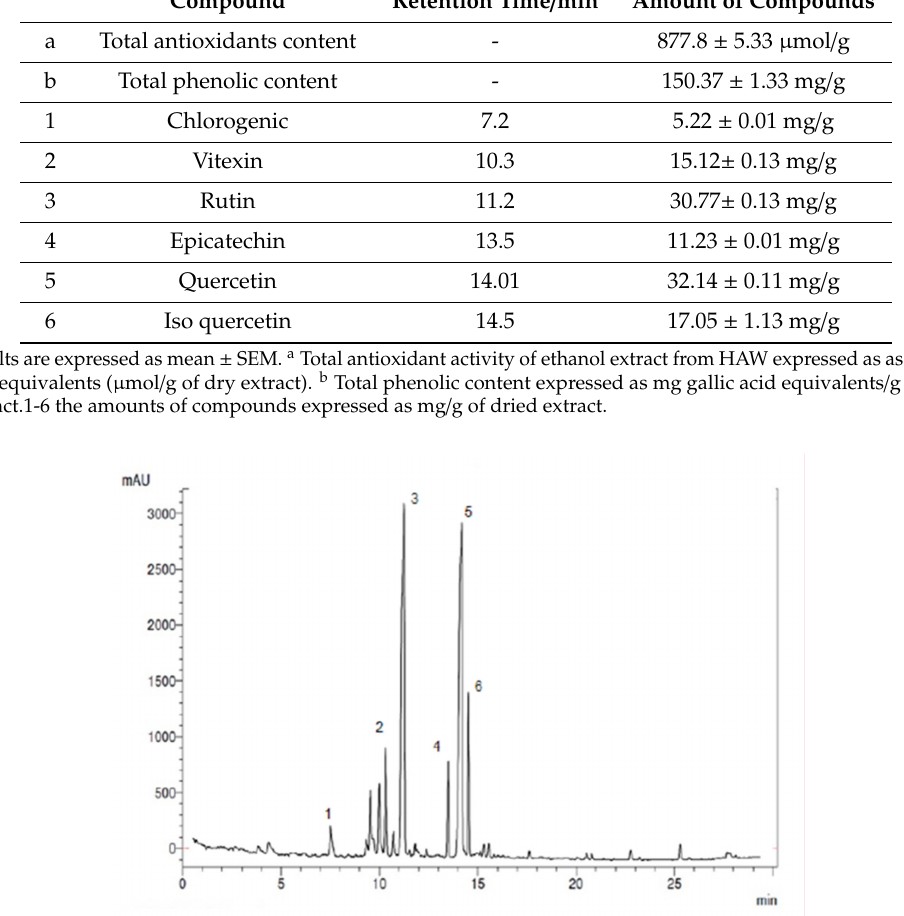
Figure 6. The typical HPLC-UV chromatogram of compositional polyphenols presented in HAW